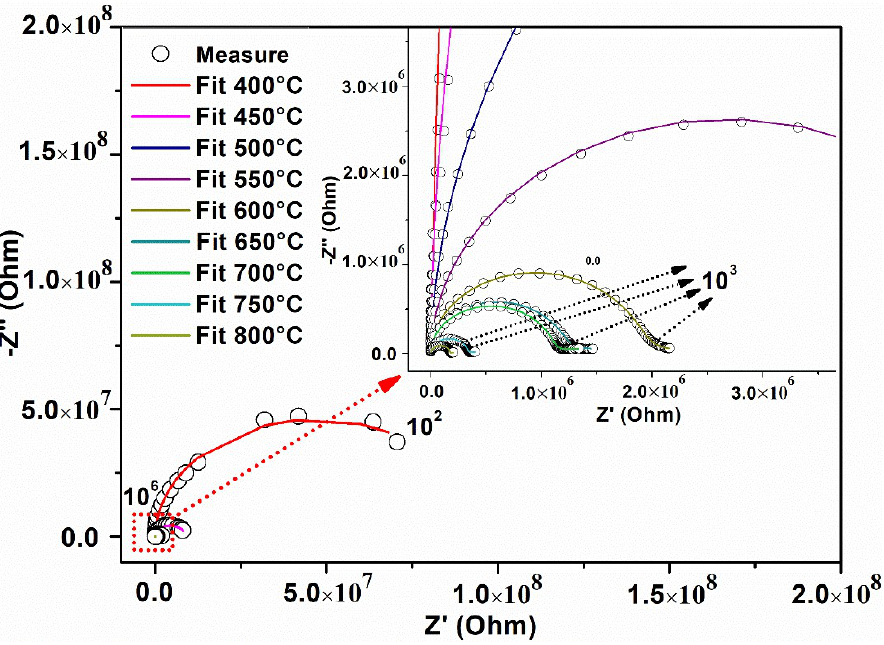
Figure 10. The electrochemical impedance spectroscopy of Bi 1.5 Y 0.5 O 3 film with a thickness of 1.72 μm varies with the measured temperature range from 400–800 °C. Table 3. The conductivity and resistance of Bi 1.5 Y 0.5 O 3 film with a thickness of 1.72 μm.